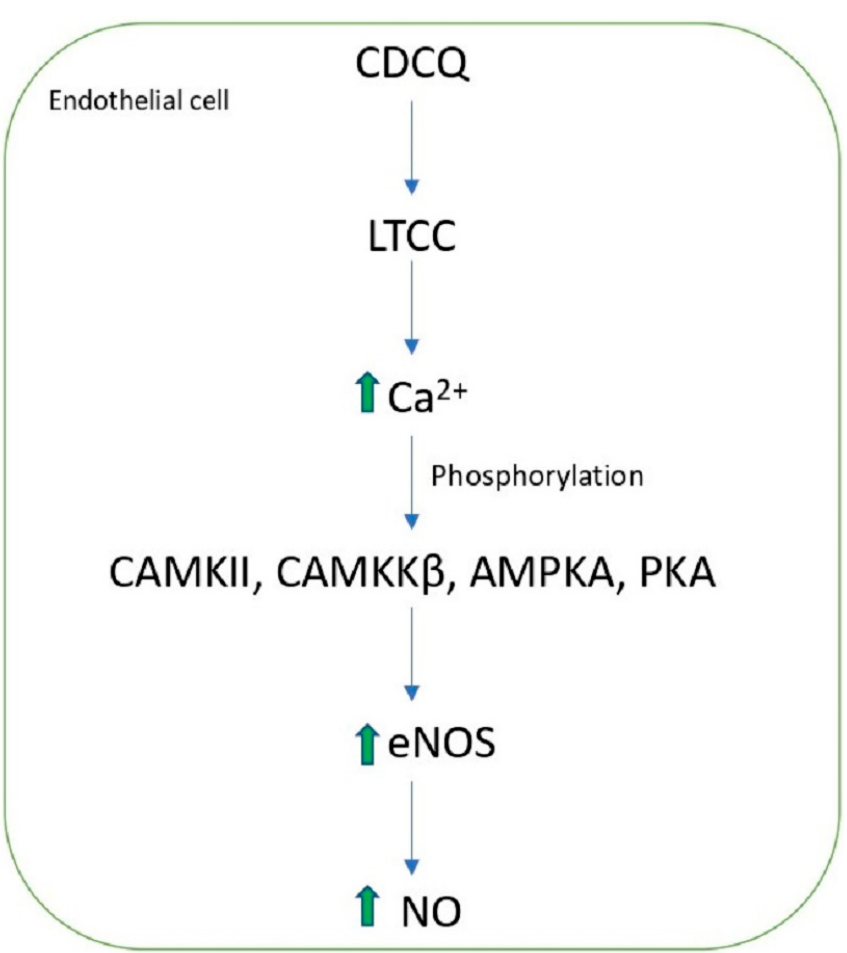
Figure 3. 3 ‐ caffeoyl ‐ 4 ‐ dicaffeoylquinic acid ( CDCQ ) mechanism on eNos and NO in endothelial